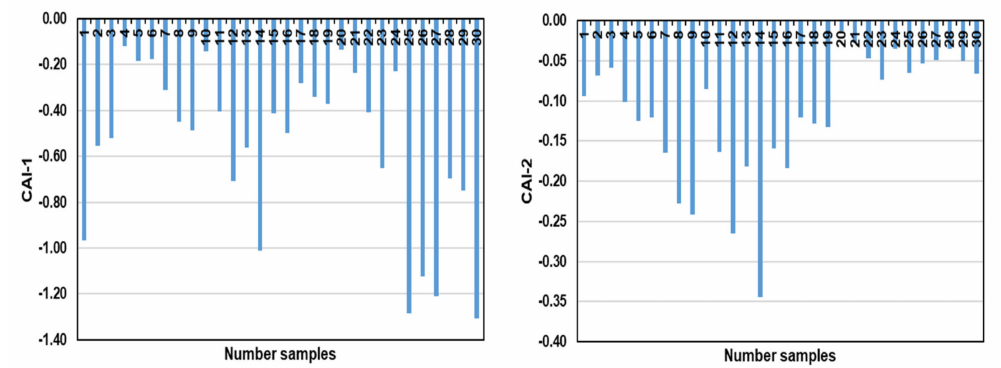
Figure 5. Chloro-alkaline indices plot.